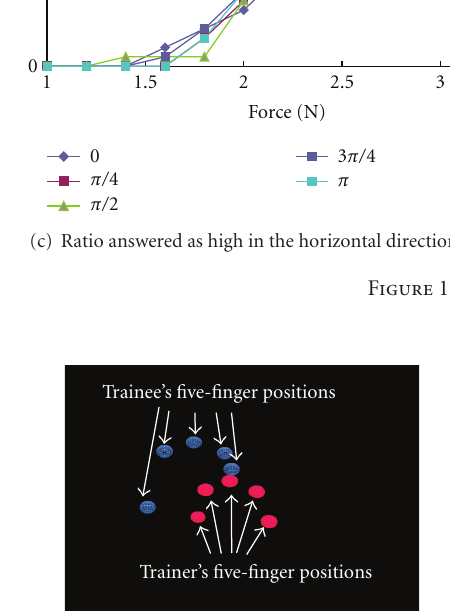
Figure 13: Visual cues for position tracking.